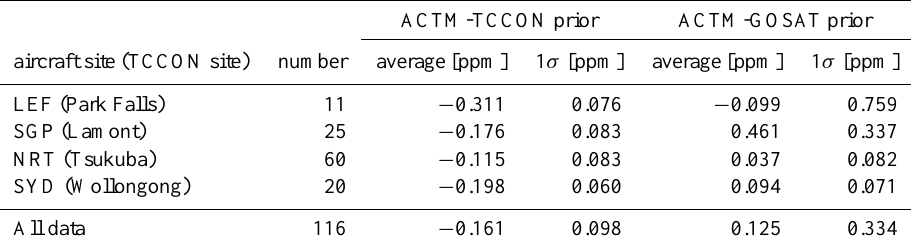
Table 3. The average and 1 standard deviation (1 σ) of the differences of aircraft-based XCO 2 calculated by using ACTM, a priori profiles of TCCON, and a priori profiles as in the GOSAT retrieval system in the stratosphere and mesosphere at each aircraft observation site.